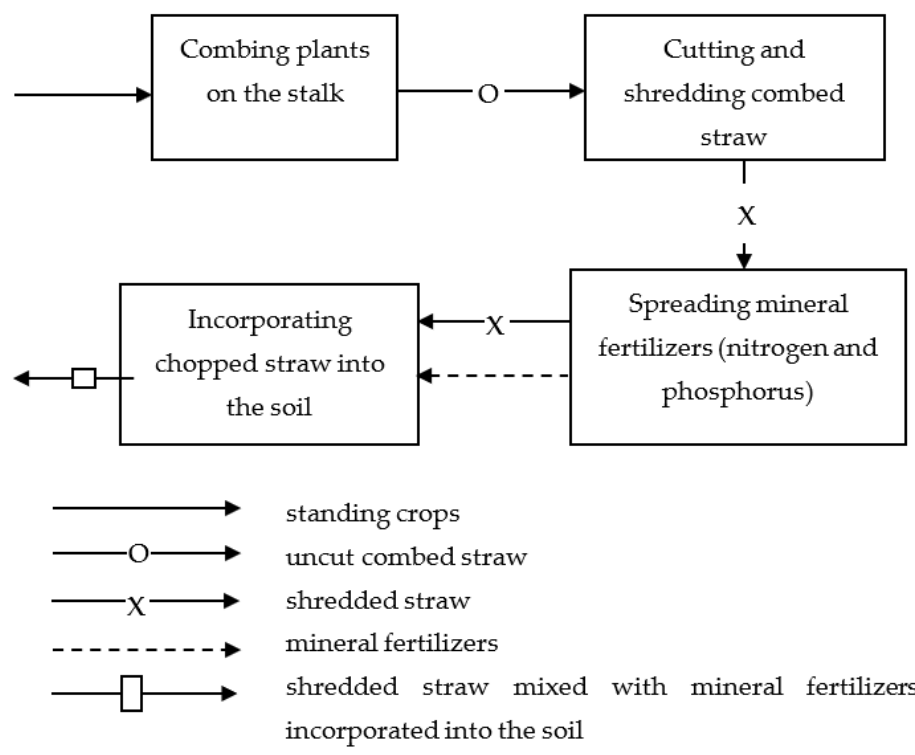
Figure 6. Block diagram of harvesting combed straw.